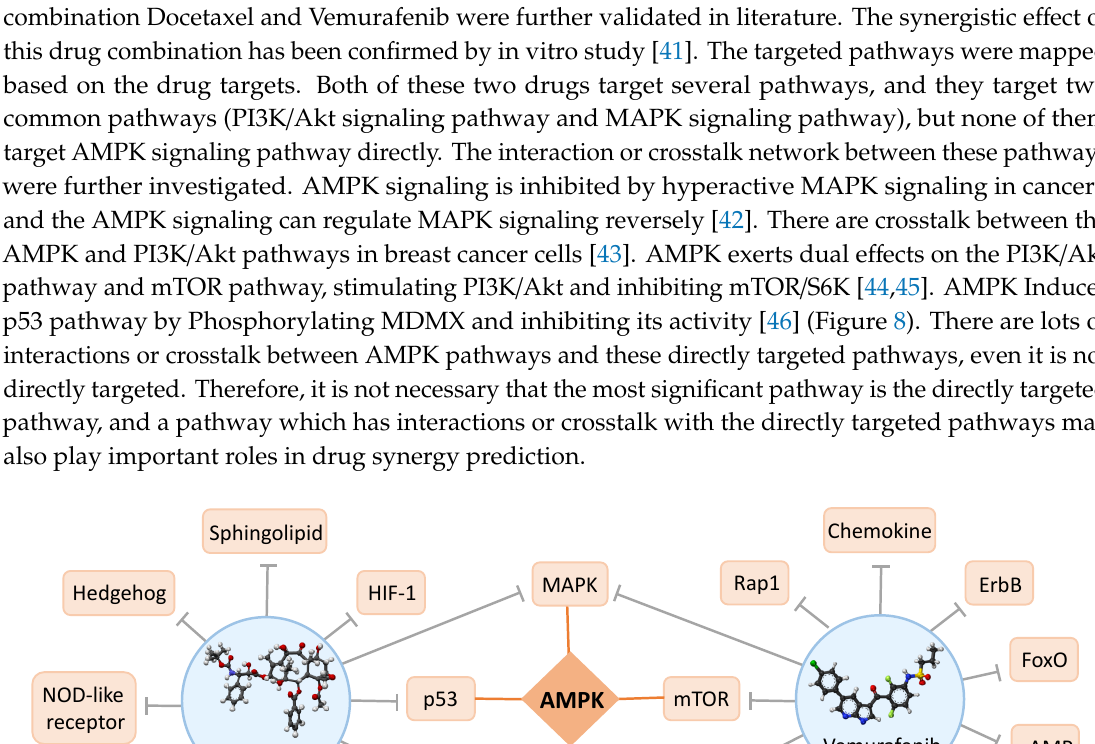
Table S1: The overall p -values of genes based on gene expression and